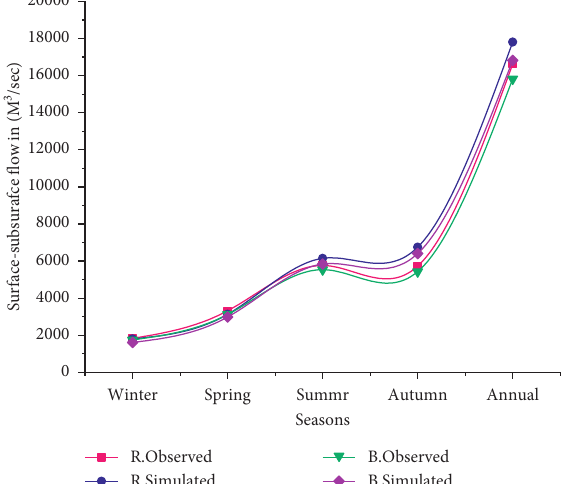
Figure 8: Compression between simulated surface flow and observed flow data, and estimated base flow against simulated